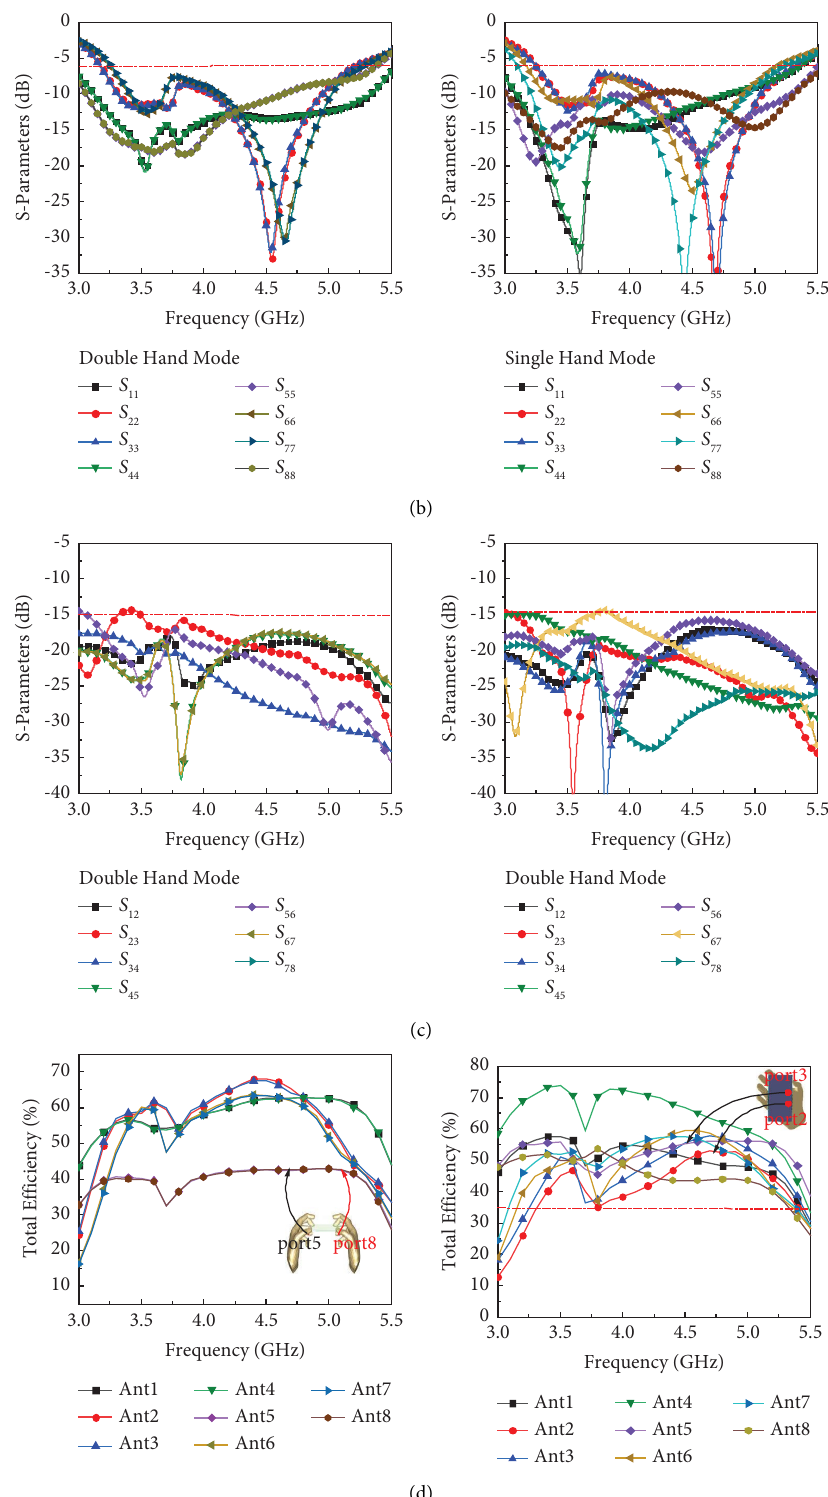
Figure 14: Two diferent representations of a handheld smartphone. (a) Dual-hand mode (DHM) and single-hand mode (SHM). (b) S- parameters of DHM and SHM. (c) Isolation degree of DHM and SHM. (d) Total efciency of DHM and